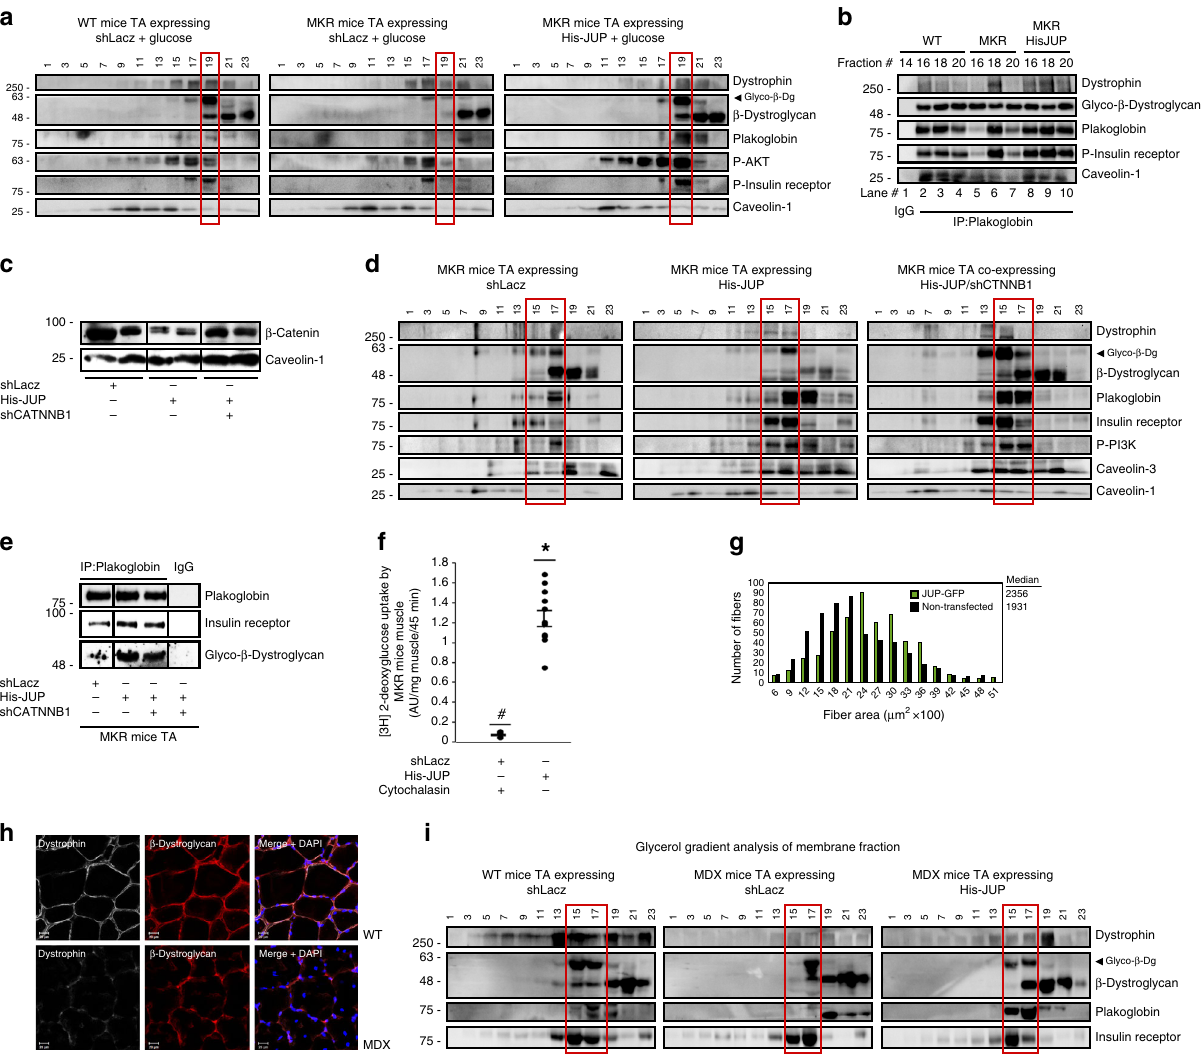
Fig. 5 Overexpression of plakoglobin alone enhances DGC-insulin receptor association and insulin signaling in muscles from MKR or mdx mice. Muscles from WT or diabetic MKR mice were transfected with 6His-plakoglobin (His-JUP) or control (shLacz) plasmids (contralateral limbs). a Mice were injected with glucose (1 mg/g body weight) and membrane extracts from transfected muscles were analyzed by glycerol gradient and immunoblotting. n = three independent experiments. b Plakoglobin immunoprecipitation from glycerol gradient fractions presented in a . n = two independent experiments. c – e Membrane extracts from muscles expressing shLacz or β -catenin shRNA (shCTNNB1), with or without the co-electroporation of His-plakoglobin, were analyzed by immunoblotting ( c ), glycerol gradient fractionation ( d ), and immunoprecipitation ( e ). Black lines indicate the removal of intervening lanes for clarity and presentation purposes. n = two independent experiments. f [ 3 H]-2-deoxyglucose uptake by muscles expressing shLacz in the presence of cytochalasin B (a competitive inhibitor of regulated glucose transport into cells) or His-JUP is plotted as ratio to shLacz control, which was not treated with cytochalasin B. Data are presented as AU/mg muscle/45 min. Data are mean ± SEM, n = 11 mice for His-JUP and shLacz, n = 4 mice for shLacz treated with cytochalasin B, * P = 0.01 and # P = 0 vs. shLacz in the absence of cytochalasin B, by one-tailed t test. n = two independent experiments. g Overexpression of plakoglobin in muscles from MKR mice attenuates the reduction in fi ber size. Measurement of cross-sectional area of 530 fi bers expressing His-JUP (also express GFP; green bars) vs. 530 non-transfected fi bers (black bars) in the same muscle. Data are acquired from seven mice. h Cross-sections of muscles from WT or mdx mice were immunostained with antibodies against dystrophin and β -dystroglycan (bar, 20 μ m). n = two independent experiments from two different mice (representative confocal images are shown). i Membrane extracts from muscles expressing shLacz or His-JUP from WT and mdx mice and analyzed by glycerol gradient fractionation and immunoblotting. Transfected mdx mice muscles are from contralateral limbs. n = two independent